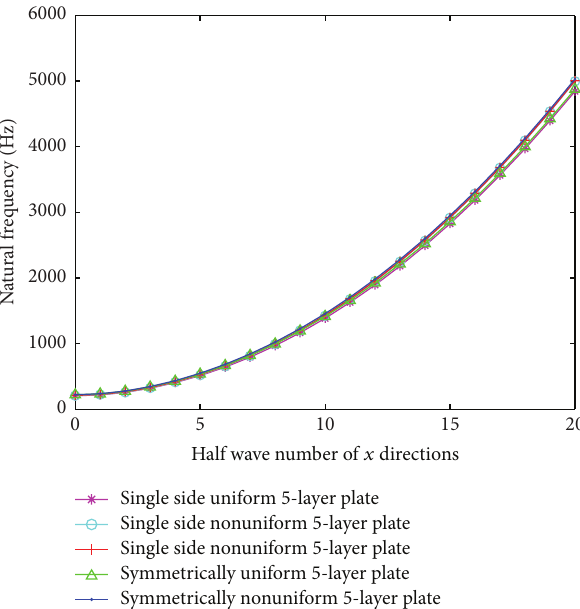
Figure 13: The natural frequency of five-layered constrained damp- ing plate with various arrangement.